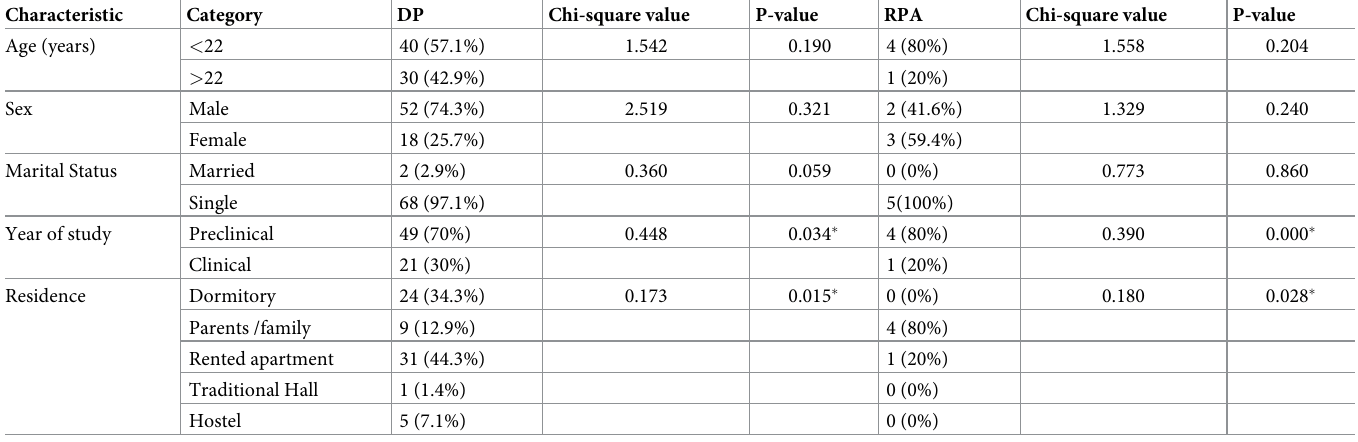
Table 5. Tabulation of students’ demographic characteristics and high levels of DP and